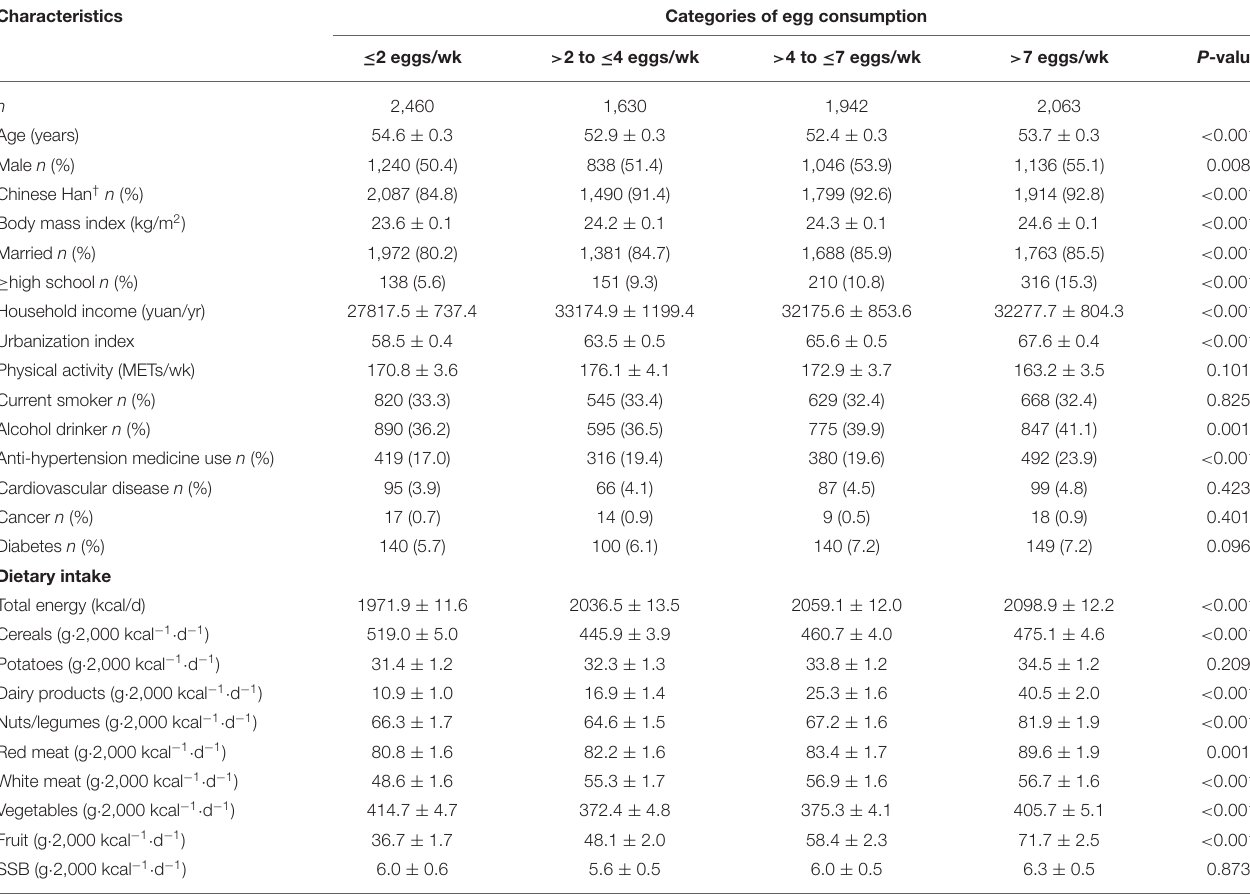
TABLE 1 | Baseline characteristics of the hypertensive patients across categories of egg consumption ( n = 8,095) * .